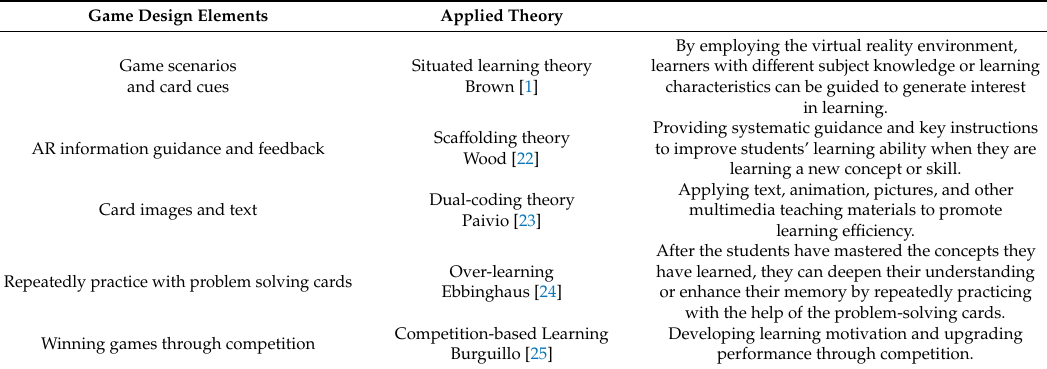
Table 1. Teaching mechanisms and the corresponding